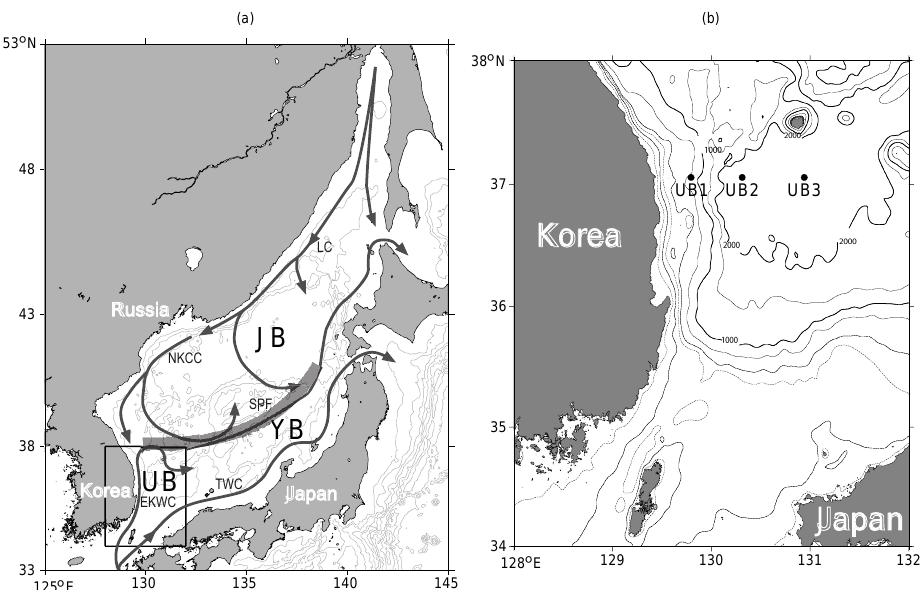
Fig. 1. Schematic map of the East/Japan Sea ( a ; modified from Lee et al., 2009) with sampling locations in the Ulleung Basin ( b ; one steep slope station, UB1 and two deep basin stations, UB2 and UB3) from May 2010 to June 2011 (LC = Liman Current, NKCC = North Korean Cold Current, EKWC = East Korean Warm Current, TWC = Tsushima Warm Current, SPF = Subpolar Front, UB = Ulleung Basin, Figure 1. Schematic map of the East/Japan Sea (a; modified from Lee et al., 2009) with 3 YB = Yamato Basin, JB = Japan sampling locations in the Ulleung Basin (b; one steep slope station, UB1 and two deep basin 4 stations, UB2 and UB3) from May 2010 to June 2011 (LC=Liman Current, NKCC=North 5 Korean Cold Current, EKWC=East Korean Warm Current, TWC=Tsushima Warm Current, 6 SPF=Subpolar Front, UB=Ulleung Basin, YB=Yamato Basin, JB=Japan Basin). 7